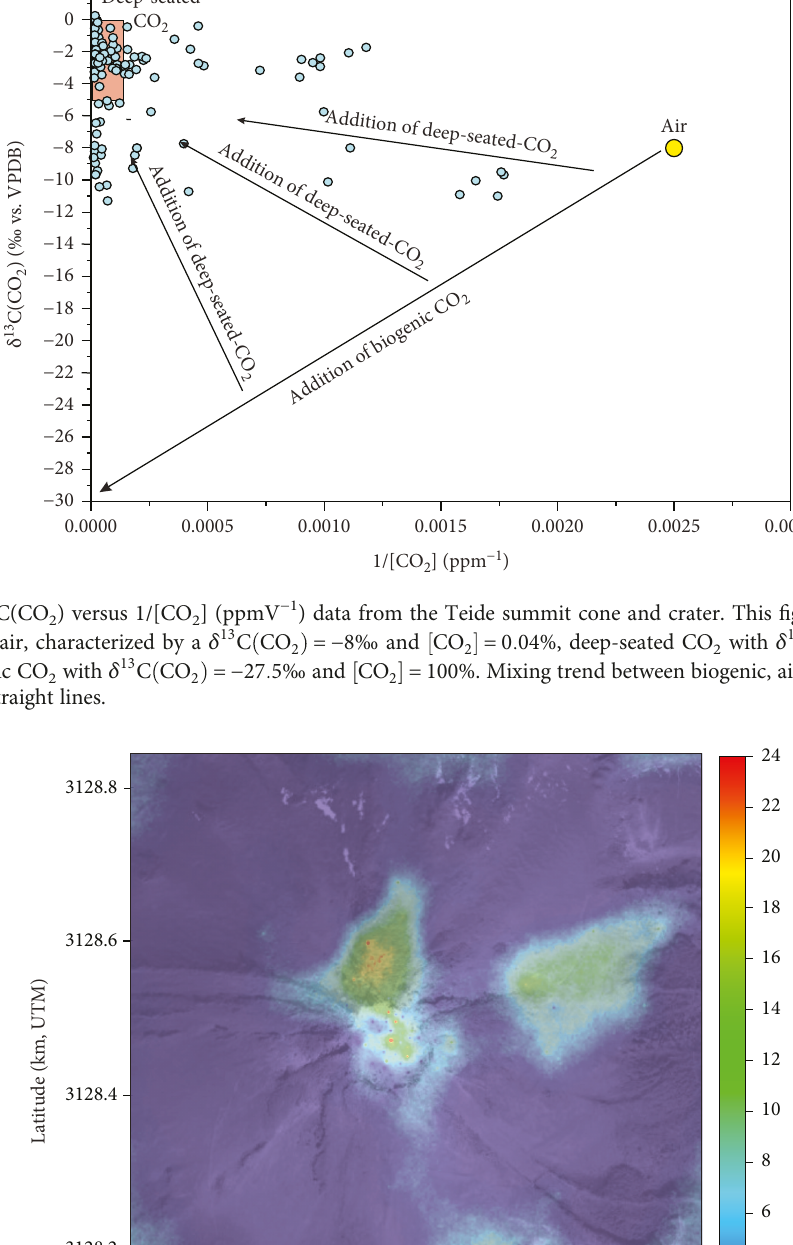
Figure 5: Di ff use 4 He emission map for the summit cone and crater of Teide